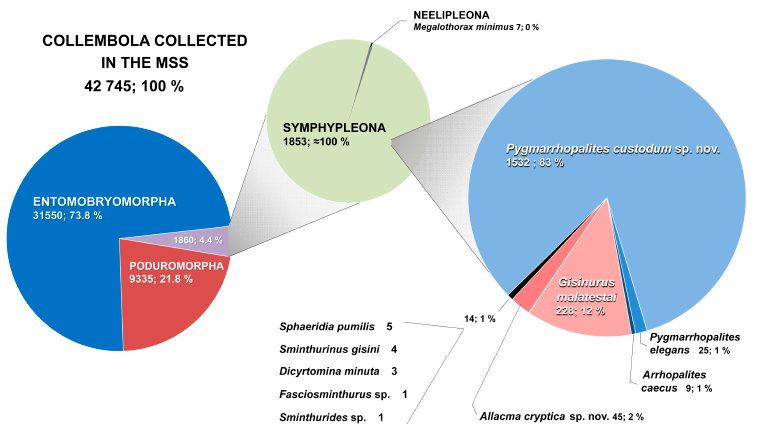
Figure 2. Diversity and abundance of Collembola collected in the MSS of the Sierra de Guadarrama National Park, with special emphasis of the Neelipleona and